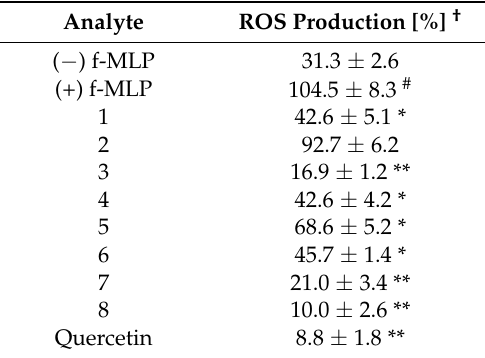
Figure 5. Inhibition of TNF- α production (%) by isolated compounds 1 – 8 in LPS-treated PMNs (mean ± S.E.M.). Dex—dexamethasone. Statistical significance of differences was established by ANOVA with Tukey’s post hoc test. * p < 0.05, ** p < 0.001 vs. (+) LPS; # p < 0.001 vs. ( − ) LPS; a p < 0.05 vs. a concentration of 25 µM. Table 3. Effect of compounds (25 µM) on f-MLP-stimulated ROS generation (mean ± S.E.M. (%)).